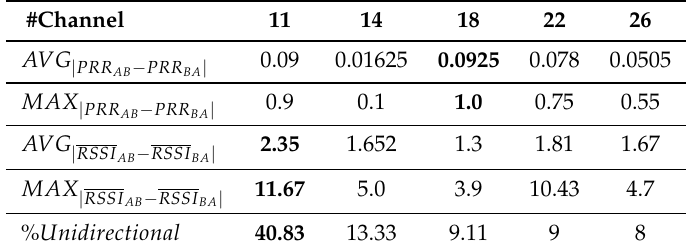
Table 3. Link asymmetry for different communication channels.